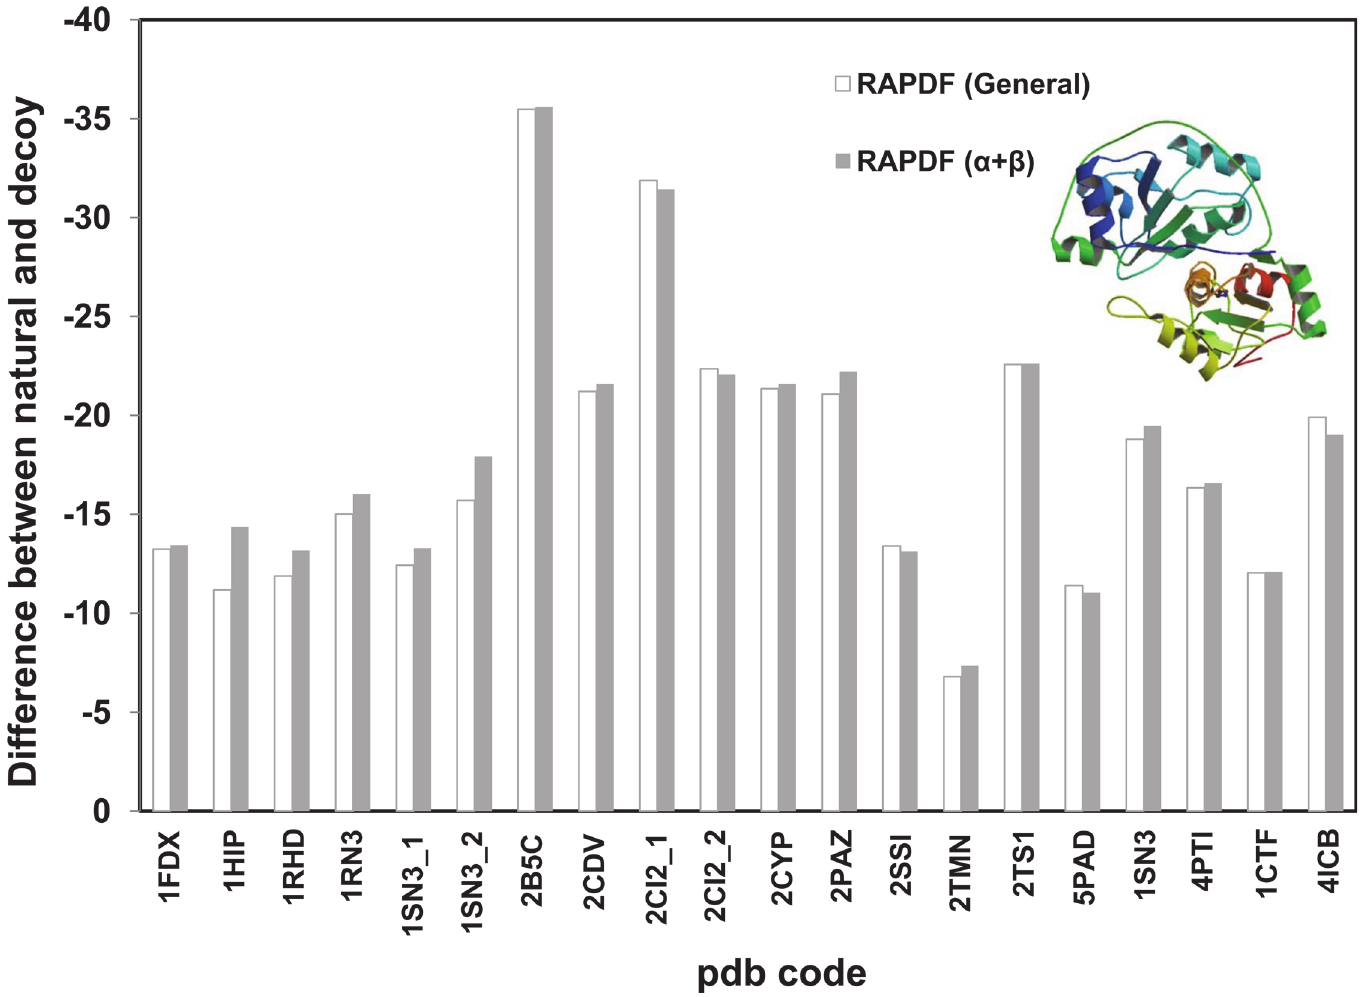
Fig 2. Evaluating the stability of α + β proteins using distance-dependant statistical potential based on α + β protein library (1271 proteins) . RAPDF ( α + β ) represents the statistical RAPDF scores calculated using the α - and β - databases. First 16 sets were single misfold decoy sets and the rest 4 sets were from multiple decoy sets with a representative decoy